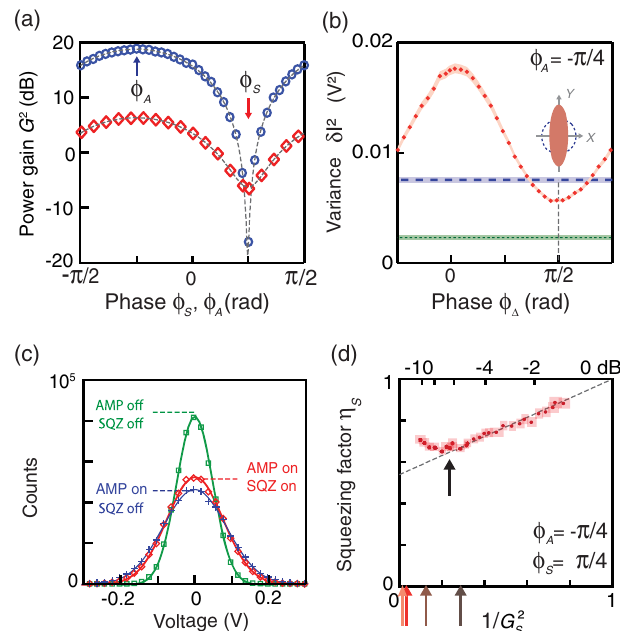
FIG. 3. Characterization of the prepared squeezed vacuum state. (a)GainofSQZ(openreddiamonds)andAMP(openbluecircles)as a function of their pump phase ( ϕ , respectively) for the chosen S;A ¼ 6 dB and pump amplitude settings, leading to a power gain G 2 S ¼ 20 dB for ϕ ¼ − π = 4 . Optimal values for the SQZ and G 2 S;A A AMP pump phases are indicated with arrows. Dashed curves are sinusoidalfits.(b)Thevariance δ I 2 inthenoiseisplottedasafunction of the difference between the SQZ and AMP pump phases ϕ ¼ ϕ − ϕ , ϕ being set at its optimal value. Data with AMP Δ S A A andSQZbothon(reddiamonds)arecomparedtothoseobtainedwith AMP on and SQZ off (blue dashed line), and with AMP and SQZ both off (green dashed line). Shaded areas represent the 5 σ measurement uncertainty. Squeezing is obtained for the optimal setting ϕ Δ ¼ π = 2 . (c) Noise histograms obtained using the optimal phases obtained above, for AMP and SQZ both off (green open squares), in which case the noise is determined by the HEMT amplifier, AMP on and SQZ off (blue crosses), in which case the noiseisthesumoftheHEMTandtheamplifiedvacuumfluctuations, and AMP and SQZ both on (red open symbols), in which case the fluctuations are reduced below the vacuum level. Gaussian fits for each are also shown (curves). (d) Using the optimal phase settings, the squeezing factor (see main text) η is measured as a function S of the SQZ power gain (red dots; rectangles represent the 5 σ measurement uncertainty) by varying the SQZ pump power. A linear fit (dashed line) for the low-gain part of the curve indicates ¼ 0 . 54 . the microwave losses between SQZ and AMP to be η loss The black arrow indicates the SQZ gain selected in the